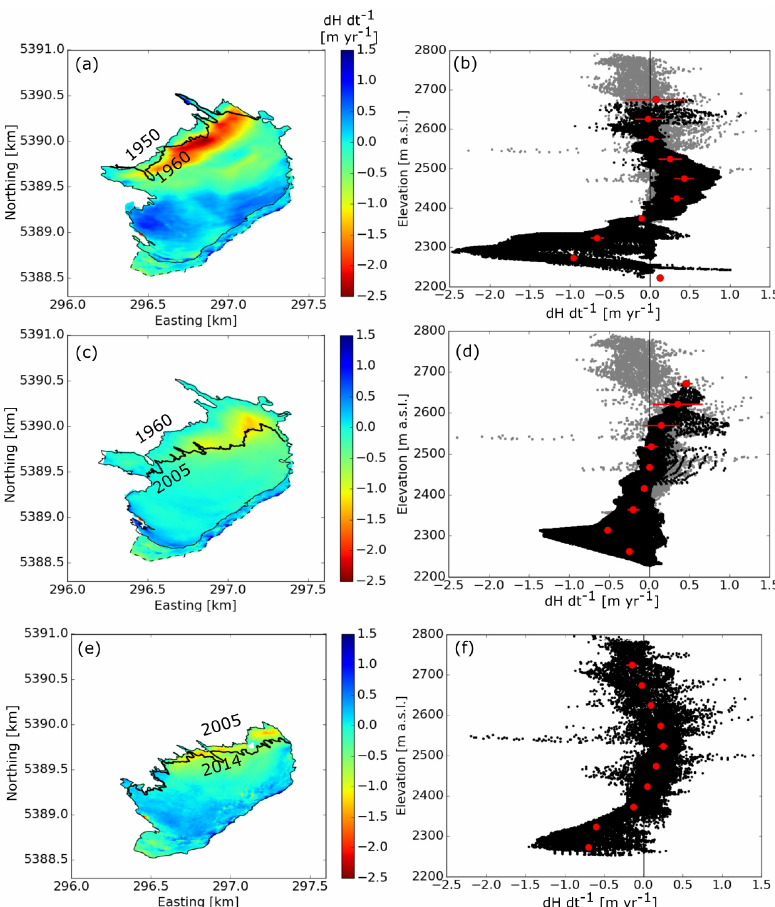
Figure 3. Elevation change over Sperry Glacier from (a, b) 1950 to 1960, (c, d) 1960 to 2005, and (e, f) 2005 to 2014. (a, c, e) show elevation change across the glacier surface, and (b, d, f) show hypsometry of elevation change. Black dots on the hypsometry figures (b, d, f) indicate individual pixels, red dots indicate elevation band means, and horizontal red bars indicate elevation band mean errors. Error is mostly smaller than, and therefore obscured by, the red dot. The missing upper section is delineated by the dotted line in (a, c) . Data from 2005 to 2014 were used to fill in this missing section. These 2005–2014 infill data are indicated by the gray dots in (b, d)